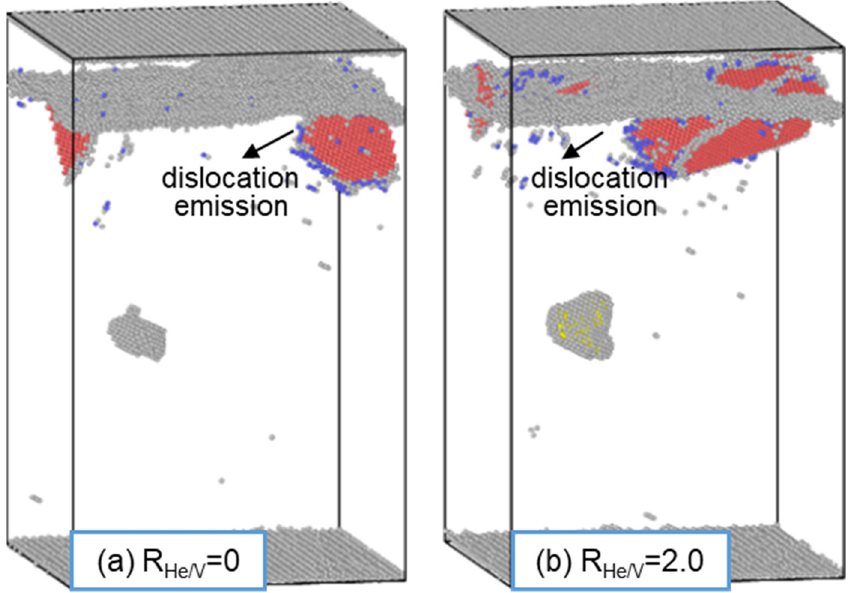
Figure 4. Dislocation emission at GB after a period of evolution (t = 5.5 ns) in ( a ) R He/V = 0 and ( b ) R He/V = 2.0.